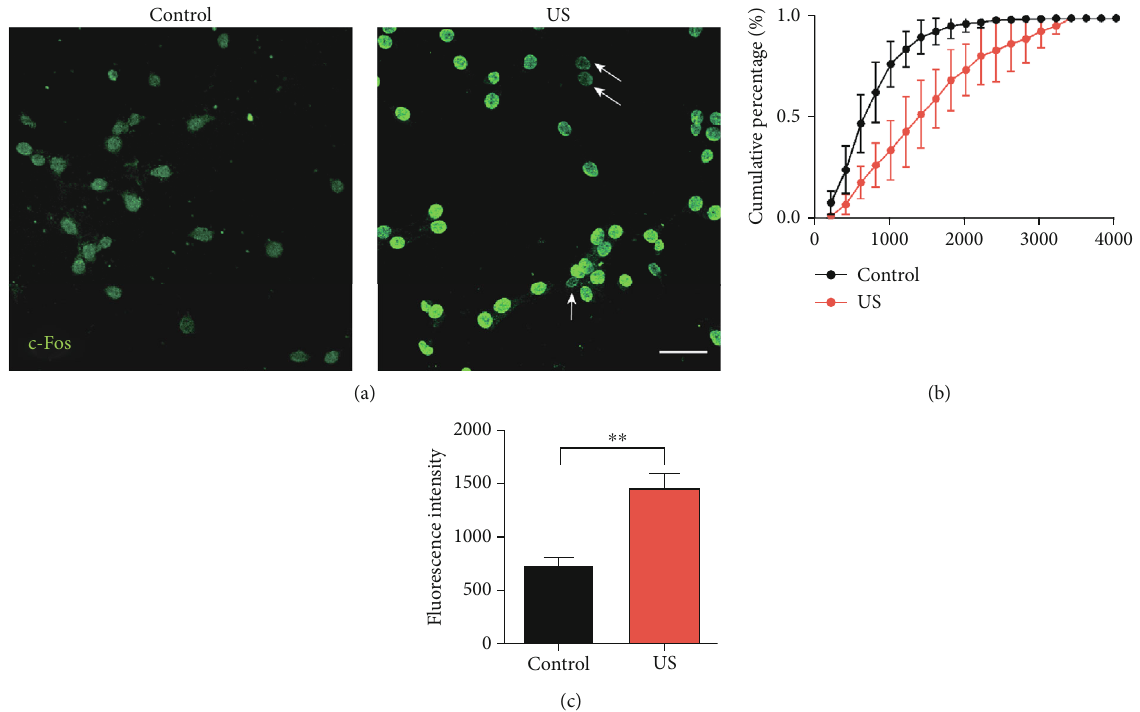
Figure 5: US stimulation increased c-Fos expression in auditory cortical neurons. (a) The representative confocal images show the immuno fl uorescence of c-Fos (green) of the cultured neurons with (right, US) or without (left, control) US stimulation. Arrows indicate the neurons without obvious increasing of c-Fos expression. Bar = 50 μ m . (b) Cumulative percentage of c-Fos fl uorescence intensity with (red line) or without (black line) US stimulation. Data are presented as the mean ± SE , n = 5 cultures. (c) The mean intensity of c-Fos fl uorescence of neurons with (red, US) or without (black, control) US stimulation. Data are presented as the mean ± SE . ∗∗ p < 0 : 01 , n = 5 , Student ’ s t